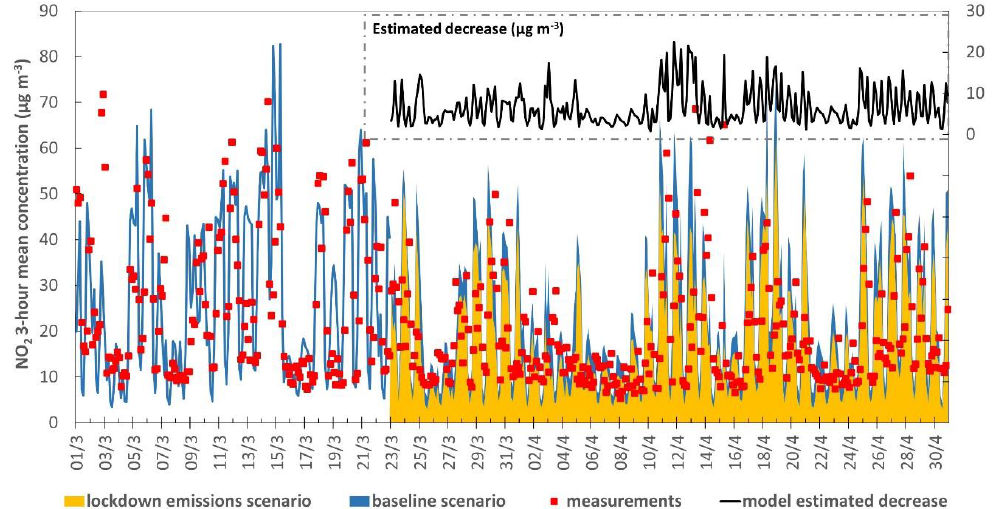
Figure 3. Mean 3-h levels of NO 2 ( µ g m − 3 ) in Athens (Thissio), based on measurements (red dots, 1 March–30 April) and city scale model simulations, using conventional emissions (blue line for 1–22 March), combined with a lockdown emissions scenario (orange area for 23 March–30April). The superimposed blue area corresponds to a hypothesis without COVID19–related measures. Also displaying (inserted panel, black line, secondary axis) the estimated net decrease comparing the two scenarios (baseline—lockdown emissions). Tick marks on x-axis correspond to 00:00 UTC + 02:00. Maps of average NO 2 concentrations and concentration differences between the two periods, as predicted by the simulation scenarios in the GAA, are presented in Figure 4. The spatial distribution of NO 2 did not change substantially between the pre-lockdown (Figure 4a) and the lockdown period (Figure 4b). The inter-comparison of the two periods (Figure 4c) shows a reduction of 30–40% over the majority of municipalities in the urbanized Athens basin (see discussion in Section 3.2). The mean reduction calculated for the urban center of Athens (red-lined area in Figure 4c) is 27%. The reduction of NO 2 levels over the Athens basin has been also indicated by columnar tropospheric NO 2 observations (TROPOMI/Sentinel–5 Precursor), with a monthly average reduction of 9% between April and March [81]. Among the reasons for the milder difference calculated using satellite data are that the reported value for March contains days with confined anthropogenic activity, and that the reported satellite means derive from a column, which horizontally is not confined in the Athens basin but also expands over the sea.